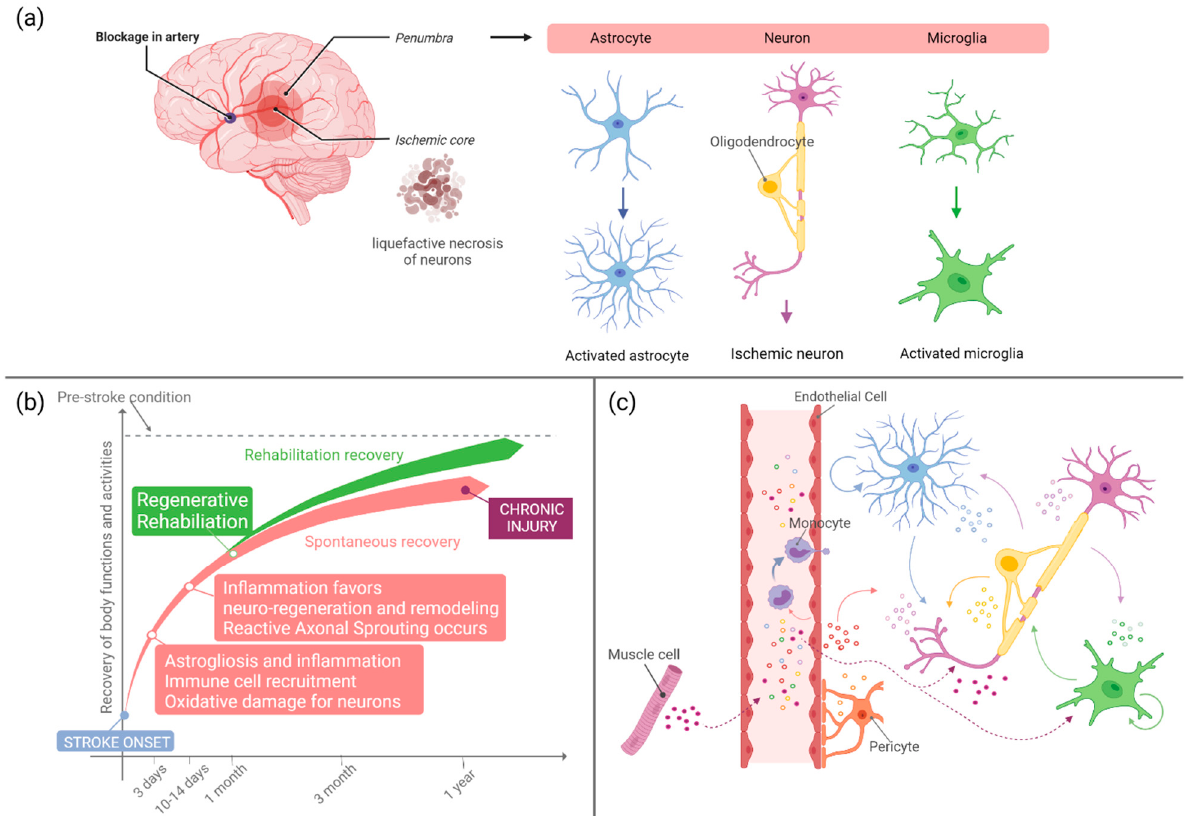
Figure 1. ( a ) Schematic representation of the cellular events occurring in the acute phase that follows a stroke event. Neurons, astrocytes, and microglia are the neural cells mostly involved in the response to injury. Astrocytes and microglia modify their metabolism and morphology towards an activated phenotype. Neurons in the ischemic core might undergo irreversible damage and liquefactive necrosis, while in the penumbra, salvageable neurons undergo acidophilic transformation and oxidative damage. ( b ) Concise summary of some of the main events occurring after stroke. Regenerative rehabilitation can significantly ameliorate stroke patient conditions leading to better therapeutic outcome and functional recovery. ( c ) Schematic illustration of the EV-mediated crosstalk occurring between neural and endothelial cells after stroke. Monocytes are recruited in the injured area. Rehabilitation and exercise stimulate EV release by skeletal muscle cells; muscle EVs that reach the brain tissue can favor recovery and resolution of inflammation. Created with BioRender.com.